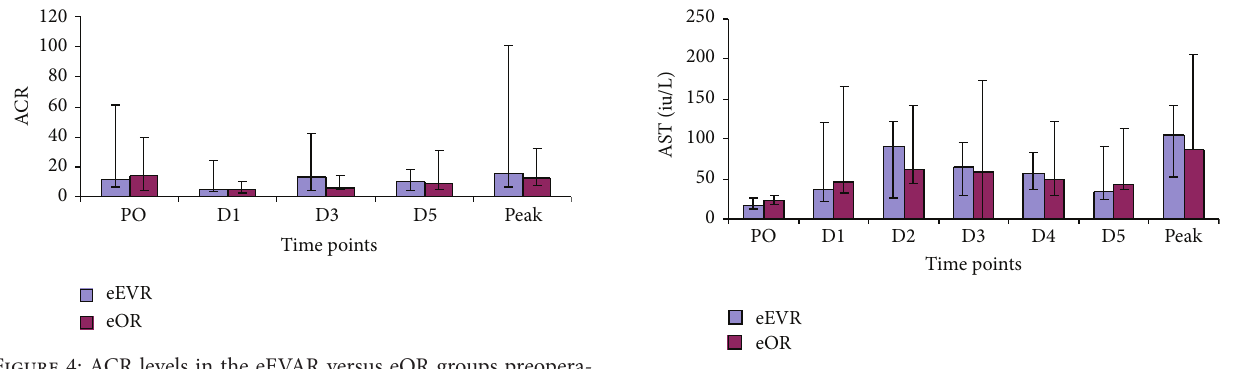
Figure 6: Serum AST expressed as median and IQR. At D1, D2, D3, D4, and D5, 𝑃 < 0.01 (eOR group versus PO). At D2, D3, D4, and D5, 𝑃 < 0.01 . At D1 𝑃 < 0.05 (eEVAR group versus PO) (Wilcoxon signed ranks